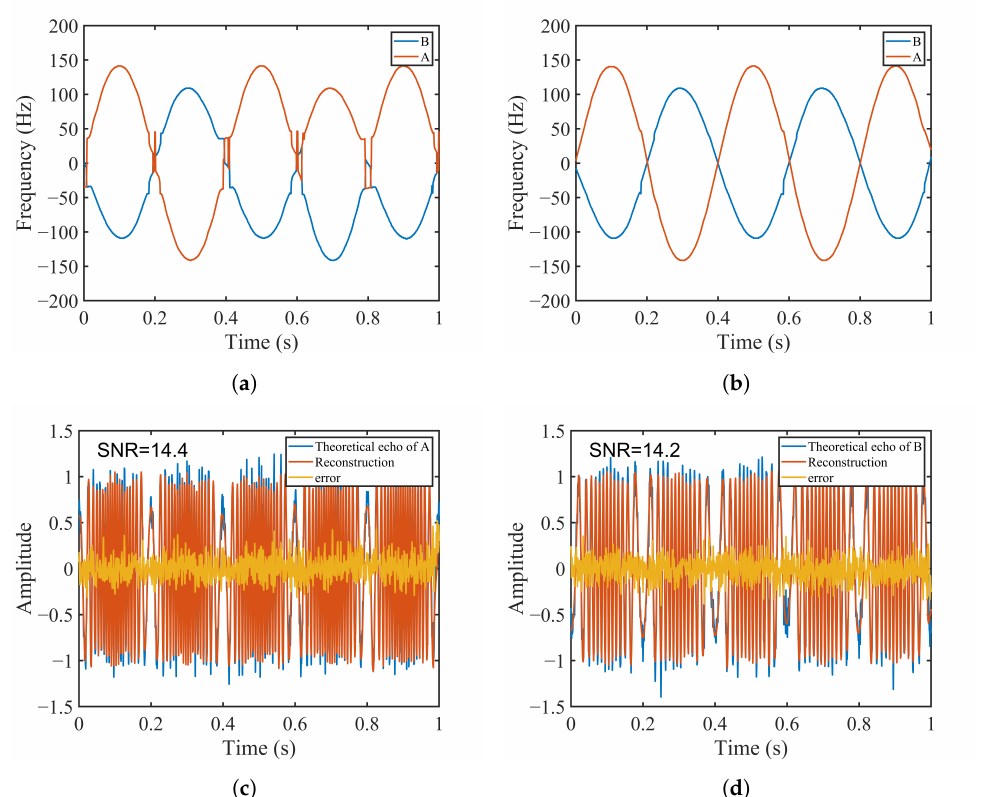
Figure 6. Ridge detection and mode reconstruction results. ( a ) Ridge detection result. ( b ) Ridge segment linking. ( c ) Mode reconstruction result of scatter A. ( d ) Mode reconstruction result of scatter